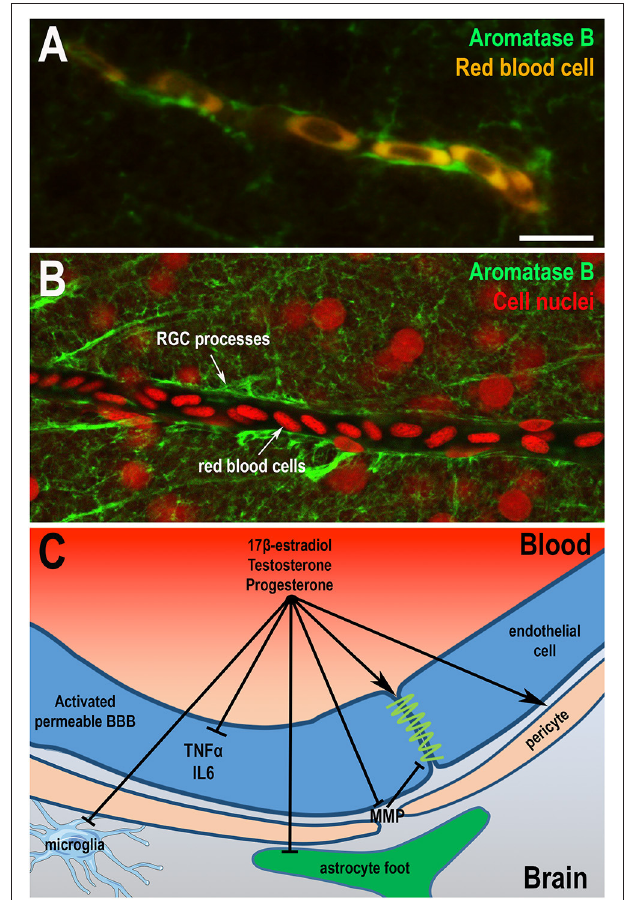
FIGURE 4 | Sex hormones restore blood-brain barrier physiology and integrity. (A,B) Aromatase B immunohistochemistry (green) on zebrafish brain highlights that radial glial processes envelop blood vessels as shown by the auto-fluorescence of red blood cells (A) or by nuclear staining (B) . These data suggest that radial glial cells could endorse the role of astrocytes in the establishment of the BBB, given the absence of astrocytic cell-type in the brain of fish. It also raises the question of the potential role of locally-produced estrogens on the BBB physiology. Scale bar: 7 µ m. (C) Sex steroids (17 β -E2, progesterone, and testosterone) display direct and indirect effects on the BBB through the restauration of thigh junctions, the inhibition of inflammatory cytokine expression and metalloproteinases production, the regulation of pericytes contraction, and consequently the modulation of cerebral blood flow. They also limit reactive gliosis through the inhibition of glial activation under pathological conditions (astrocytes and microglia). Sex steroids participate in the maintenance of a functional BBB, reducing neuroinflammation and promoting